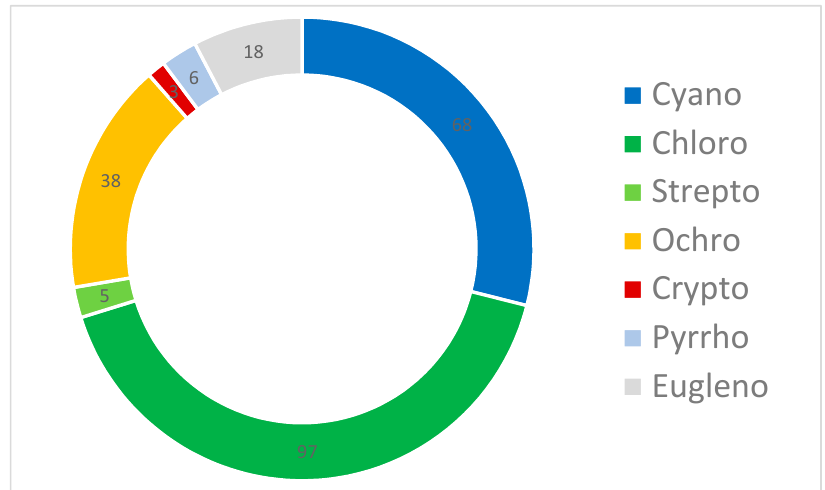
Figure 2. General phytoplankton species composition in nine shallow Bulgarian wetlands sampled in August 2019. The number of identified taxa in each phylum is shown. Legend: Cyano—Cyanoprokaryota, Chloro—Chlorophyta, Strepto—Streptophyta, Ochro—Ochrophyta (incl. classes Bacillariophyceae (diatoms)—28, Chrysophyceae (golden algae)—4, Xanthophyceae (yellow- green algae)—5, Eustigmatophyceae − 1, Crypto—Cryptophyta, Pyrrho—Pyrrhophyta and Eugleno—Euglenophyta.